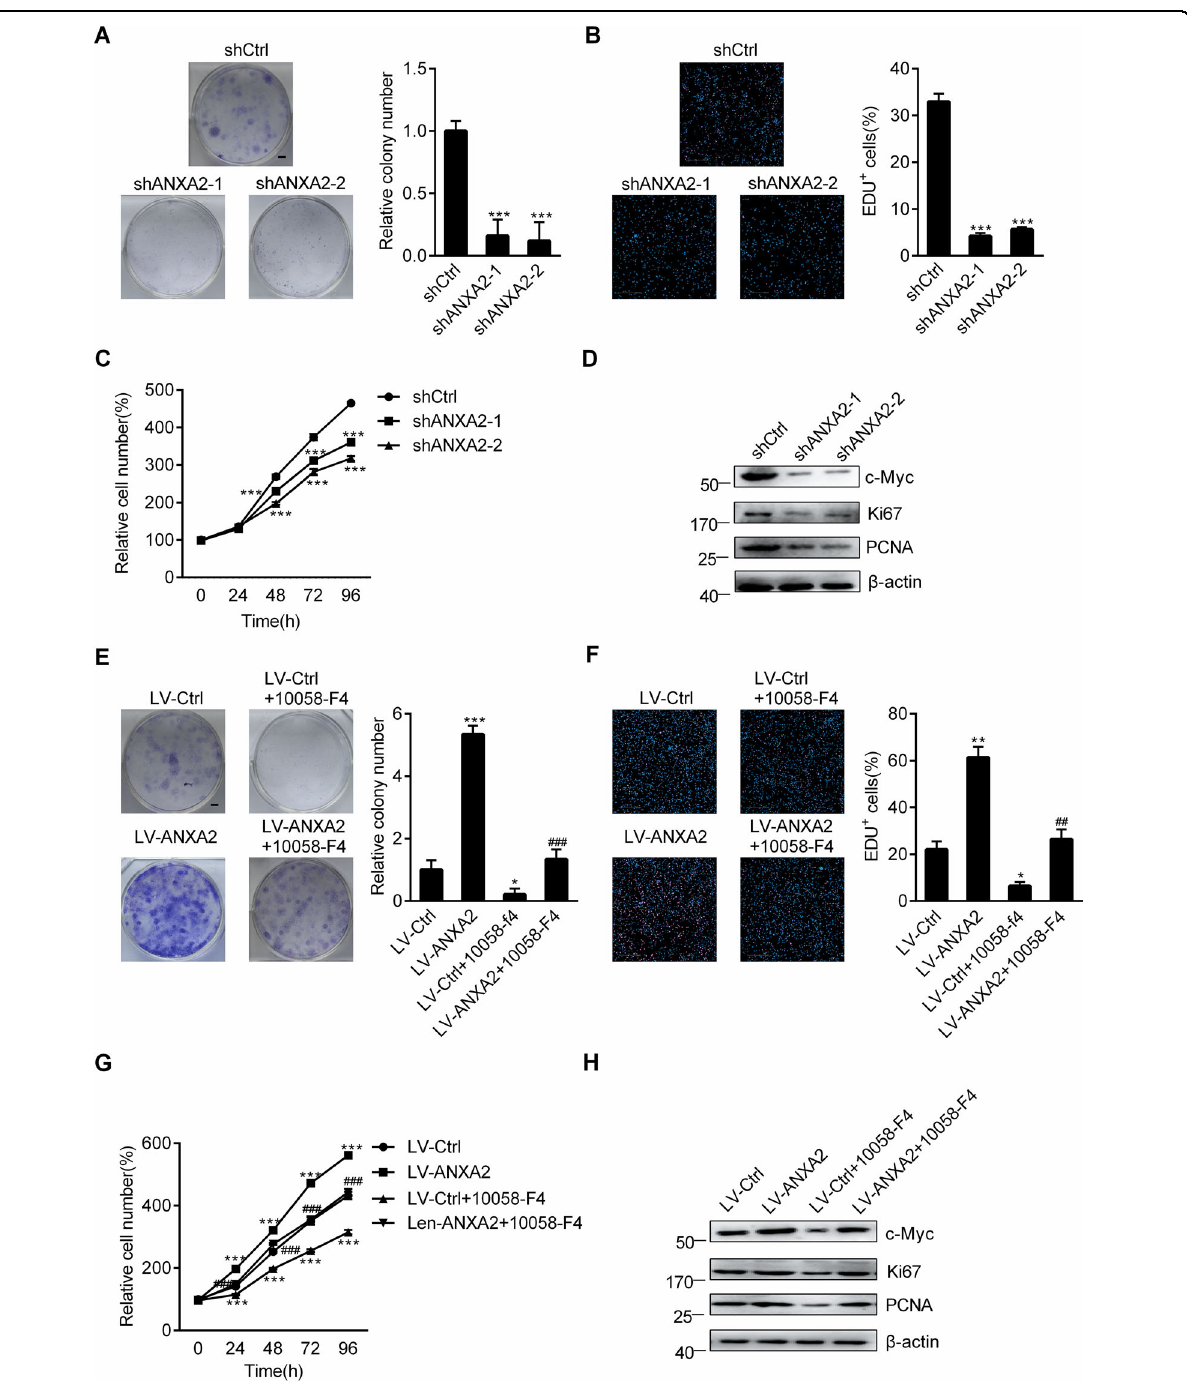
Fig. 1 ANXA2 drives glioma cell proliferation in a c-Myc-dependent manner. A – C Cell proliferation was assessed in stable ANXA2-silenced U118 cells, as shown by colony formation ( A ) (Scale bar = 5 mm), EdU immuno fl uorescence staining ( B ) (Scale bar = 200 μ m) and CCK-8 ( C ) assays. ∗∗∗ P < 0.001 vs. shCtrl. D Western blot analysis of c-Myc and proliferation markers (Ki67 and PCNA) in stable ANXA2-silenced U118 cells. E – G Effects of 24 h of 10058-F4 treatment at 10 μ M on the proliferation of U118 cells stably transfected with control or ANXA2 lentiviruses shown by colony formation ( E ) (Scale bar = 5 mm), EdU immuno fl uorescence staining ( F ) (Scale bar = 200 μ m), and CCK-8 ( G ) assays. ∗ P < 0.05; ∗∗ P < 0.01; ∗∗∗ P < 0.001 vs. LV-Ctrl, ### P < 0.001 vs. LV-ANXA2. H Effects of 24 h of 10058-F4 treatment at 10 μ M on the protein levels of c-Myc and proliferation markers (Ki67 and PCNA) in U118 cells stably transfected with control or ANXA2 lentiviruses. Error bars represent the standard error of the